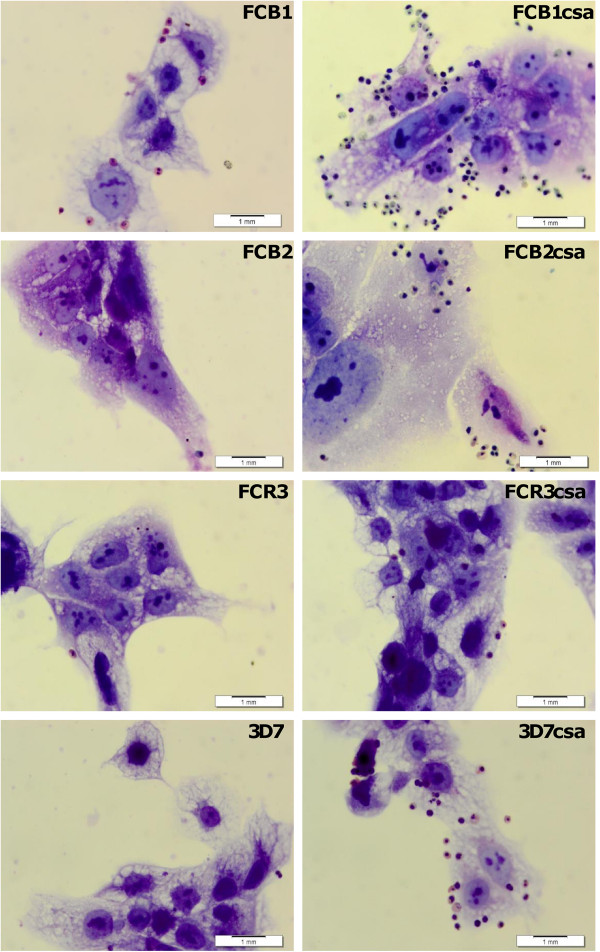
Adhesion of Plasmodium falciparum strains to BeWo cells. Representative photographs of P. falciparum strains adherence BeWo cells at 40-50% confluence (Lab-Tek chambers) were incubated with IEs suspension and stained with Giemsa in order to quantify the number of adhered IEs in 500 nuclei. (1,000× magnification, 1 mm scale).